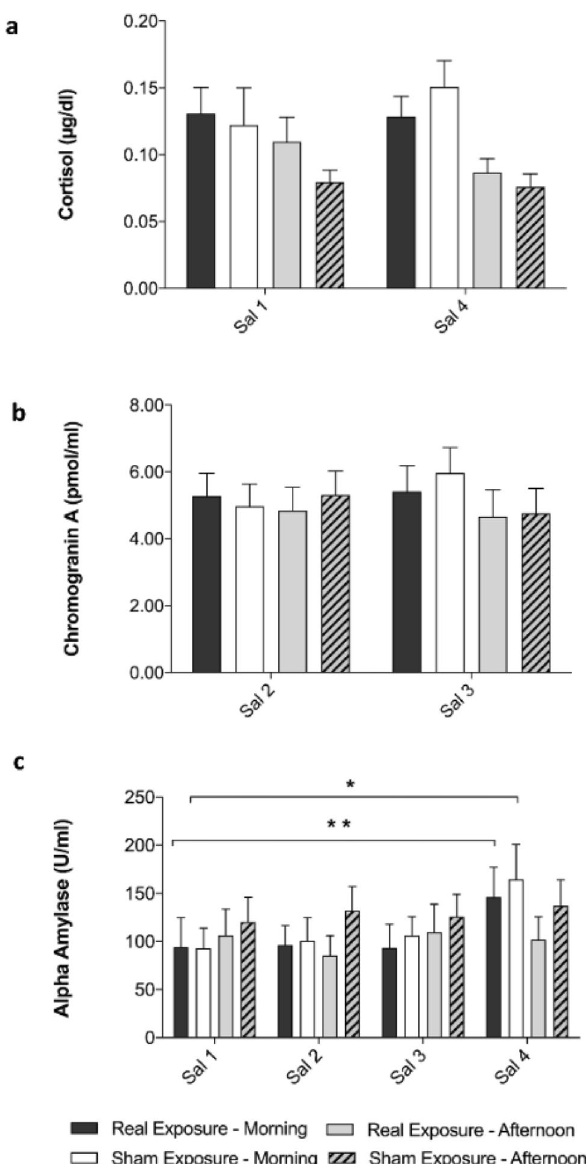
Figure 6. Results of biochemistry assays for salivary biomarkers of stress: cortisol ( a ), chromogranin A ( b ) and alpha amylase ( c ). Saliva samples (Sal) were analyzed considering samples collected during morning and afternoon experimental sessions, separately (13 and 16 subjects, respectively). Data are shown as means ± SEM. Statistical significance was set for p < 0.05 (** p < 0.01; * p < 0.05, one-way ANOVA followed by Bonferroni Multiple Comparison